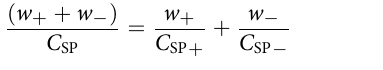
Fr ontiers in Materials |